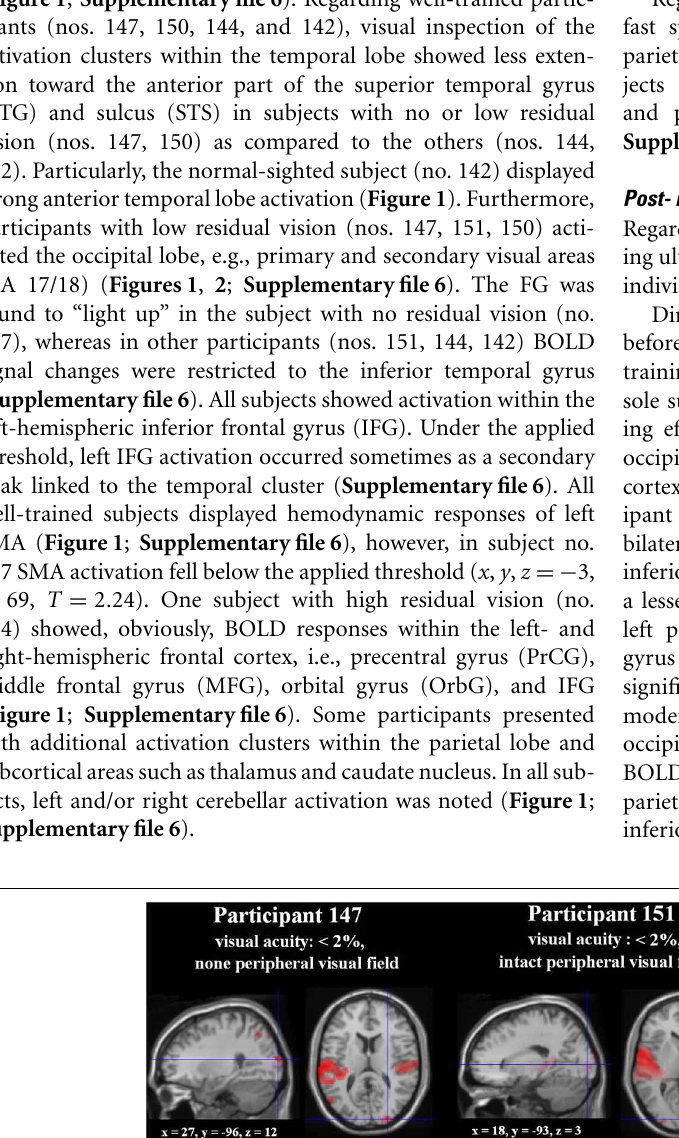
post-training (red = condition vs. baseline, green = baseline vs. condition). Threshold at p < 0 . 005 uncorrected at voxel level with an extent threshold k = 10 (for peak coordinates see Supplementary files 6 , 7